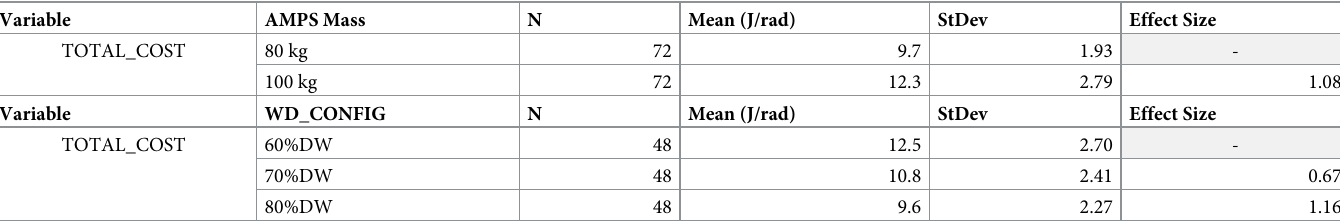
Table 10. Zero-radius turns: Cost